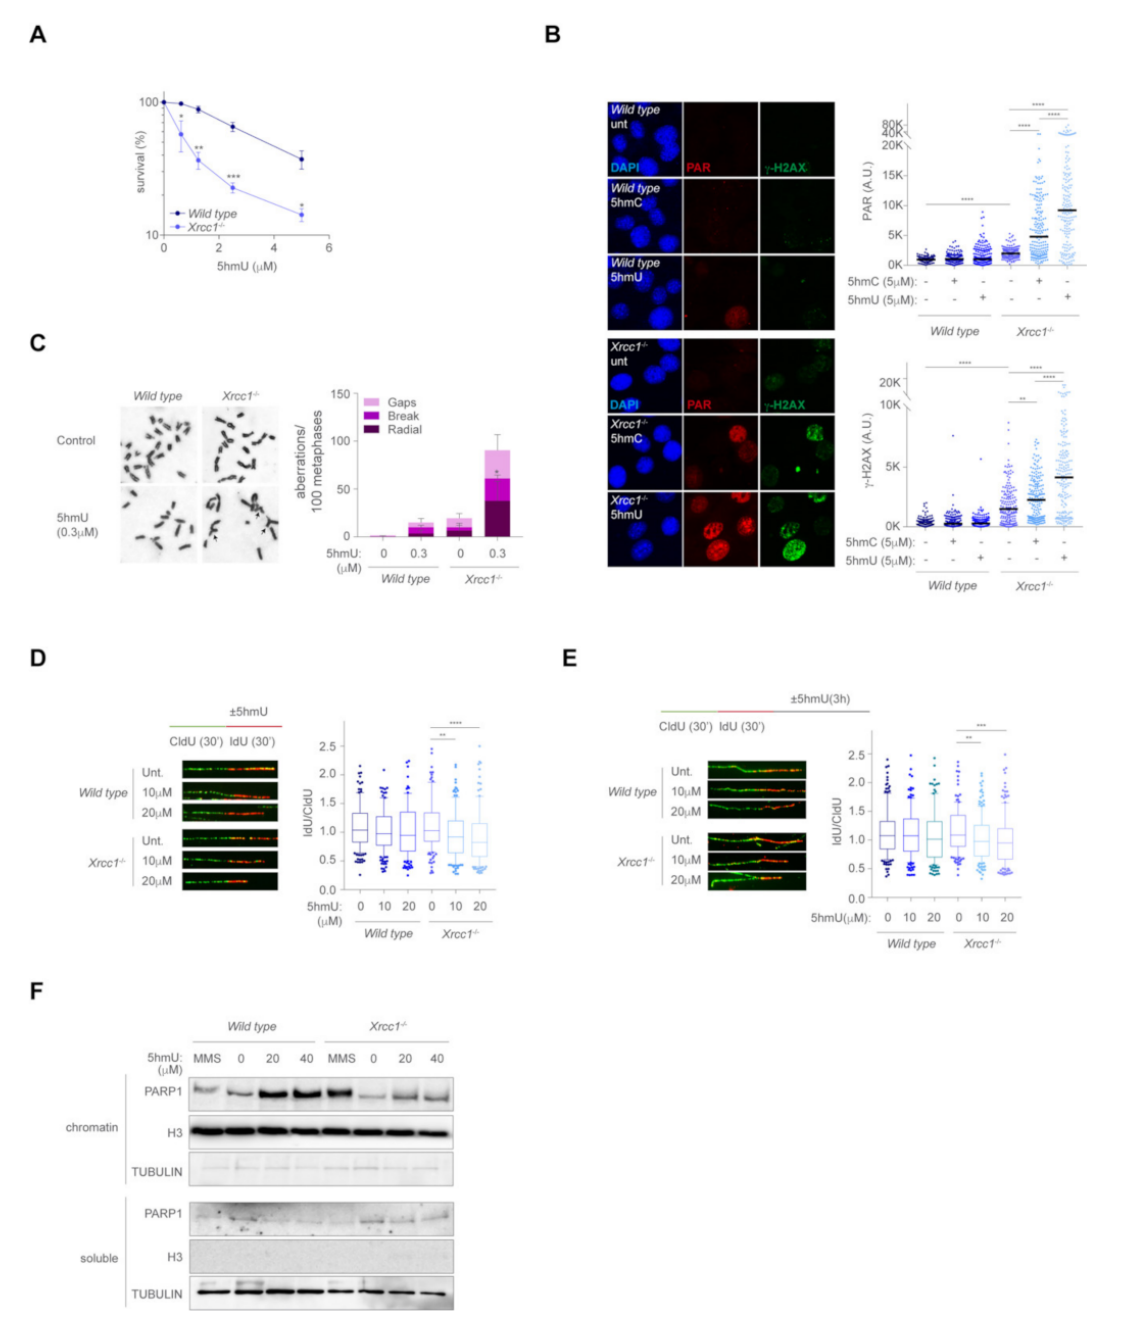
Figure 4. Xrcc1 maintains genome integrity, cell survival and replication fork stability upon 5hmU exposure. ( A ) MTT survival assay of wild type and Xrcc1 − / − MEFs treated with 5hmU at indicated doses for 3 days ( n = 3, mean ± s.e.m). ( B ) Left, representative immunofluorescence images showing PAR nuclear staining (red) and γ -H2AX (green) of wild type and Xrcc1 − / − MEFs upon exposure to 5hmC and 5hmU (5 µ M) for 3 h. DAPI (blue) stains nuclear DNA. Right, plot depicting PAR intensity signal per nucleus (top right) and γ -H2AX intensity signal per nucleus (bottom right) ( n = 150 of each of 3 biological replicates, Mann–Whitney test; central line represents median value). ( C ) Left, representative images of chromosome aberrations from wild type and Xrcc1 − / − MEFs following 5hmU treatment (0.3 µ M) for two cell cycles. Right, a bar plot of breakdown of the different types of chromosomal aberrations ( n = 50 of each of 2 biological replicates, Student’s t-test; bar represents mean ± s.e.m.). ( D ) Top left, scheme of the DNA fiber assay. Bottom left, representative images of DNA fibers from wild type and Xrcc1 − / − MEFs after increasing doses of 5hmU (10 µ M and 20 µ